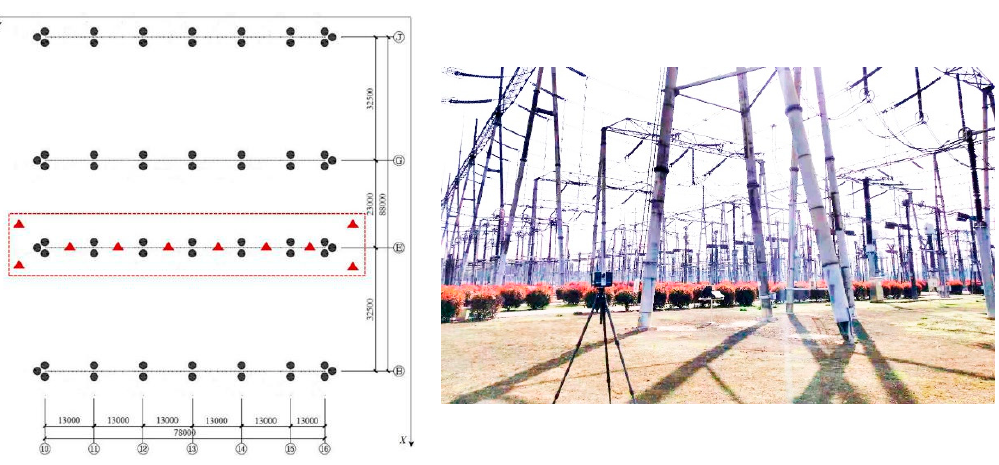
Figure 5. Scan planning.